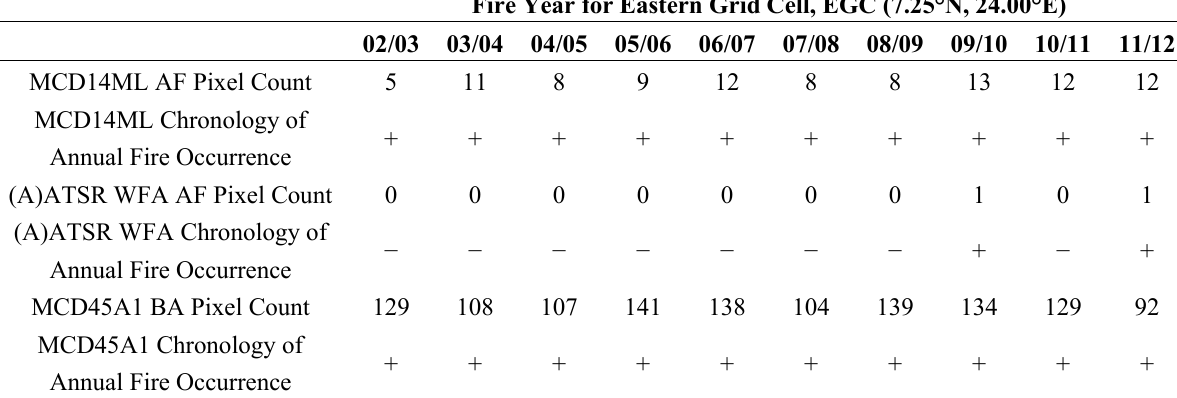
Table 1. Chronologies of annual fire occurrence derived from the MODIS active fire product (MCD14ML), the (A)ATSR active fire product (WFA), and the MODIS